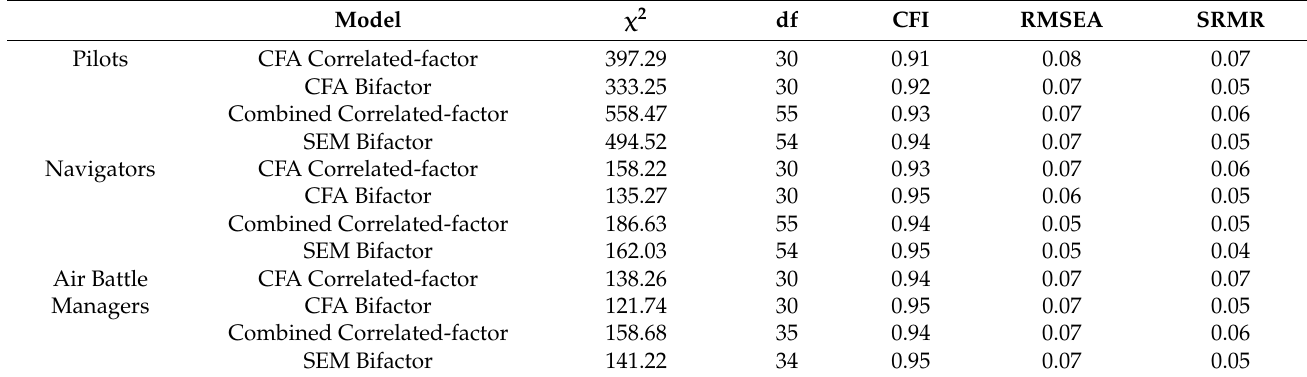
Table 1. Fit statistics of all models tested in the study.